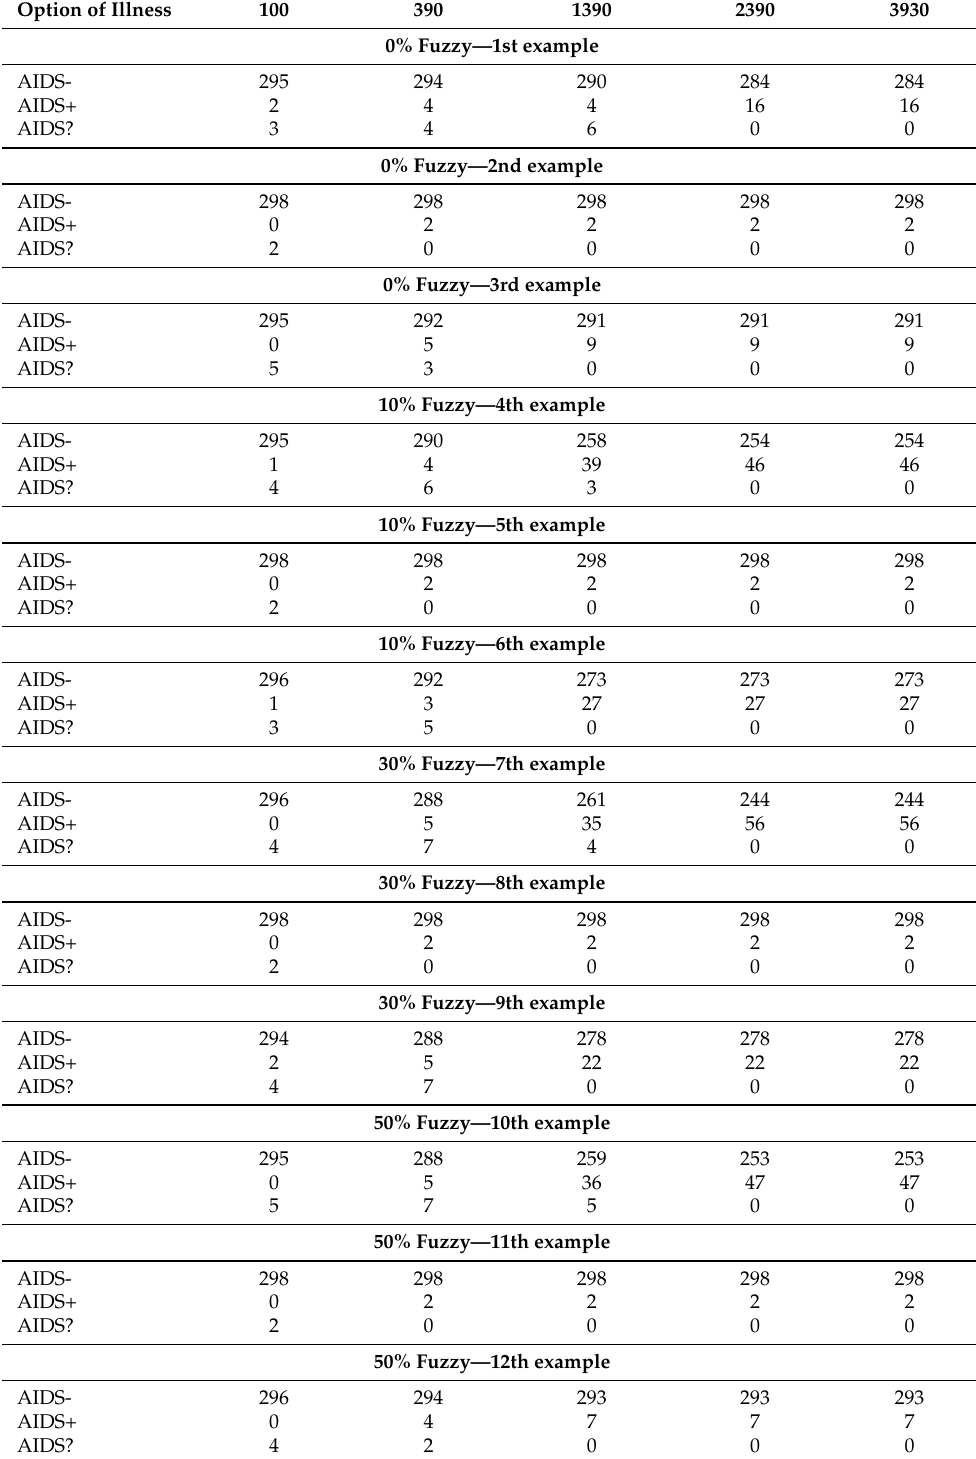
Table 5. People regarding the second scenario for a different number of